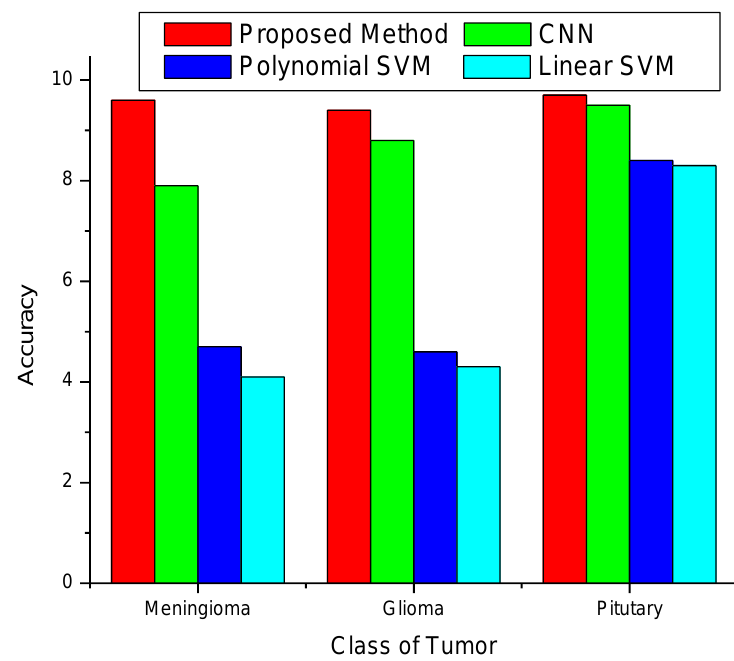
Figure 8. Accuracy of classification method.